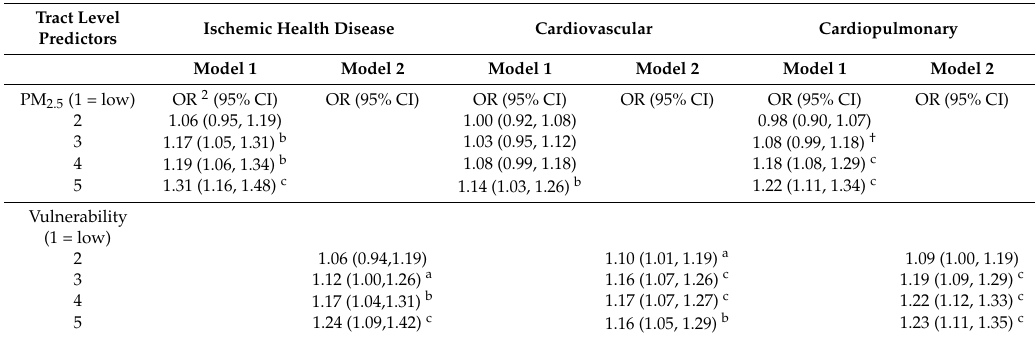
Table 2. Mortality due to ischemic heart disease, cardiovascular disease, and cardiopulmonary disease, respectively, regressed on PM 2.5 and cumulative vulnerability, adjusted for individual characteristics 1